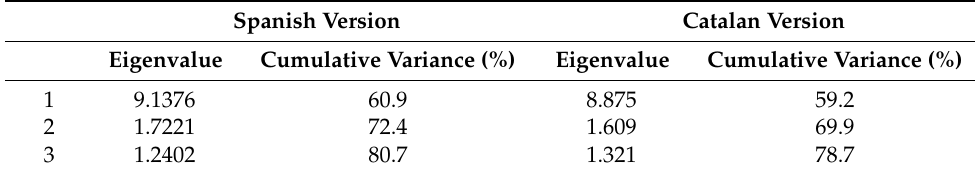
Table 3. Eigenvalues and cumulative variance of items (only shown for eigenvalues >1).